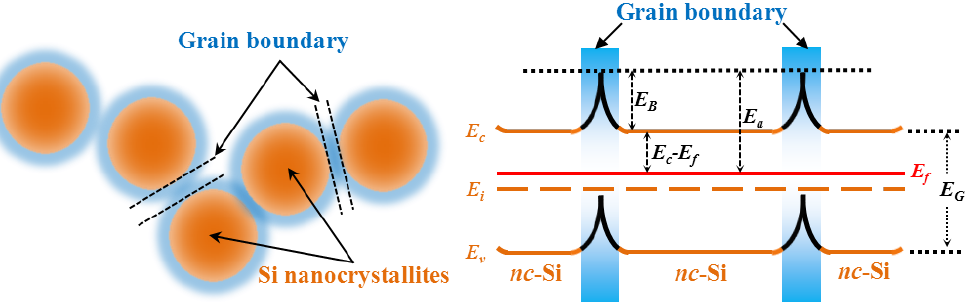
Figure 6. Schematic energy band diagram of the nc-Si films constituted by nano-crystalline phases and potential barrier caused by grain boundaries.